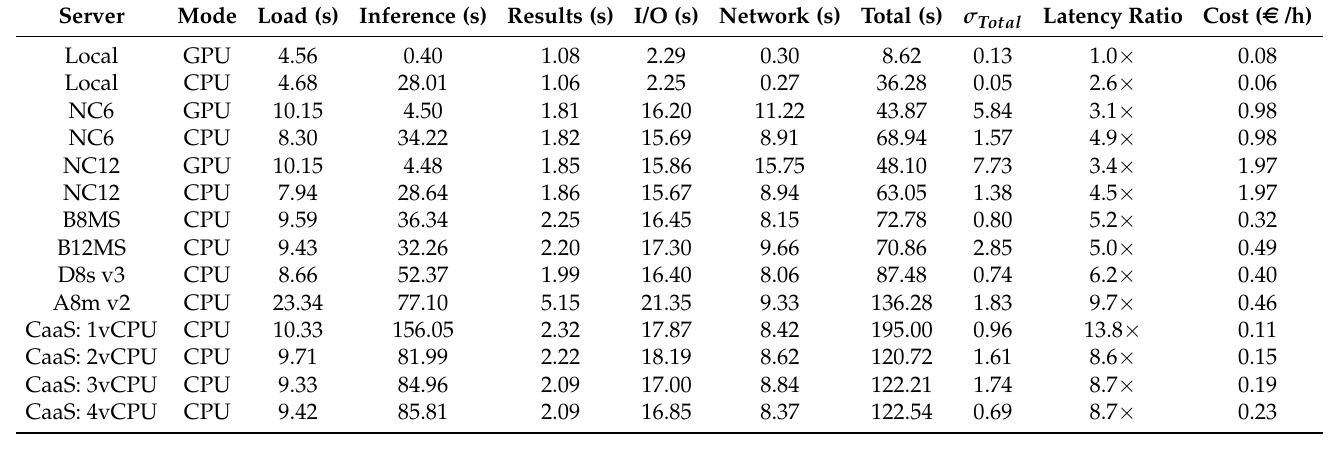
Table 7. Results of the SUT evaluation over several infrastructures using a 10,000 × 10,000 images.